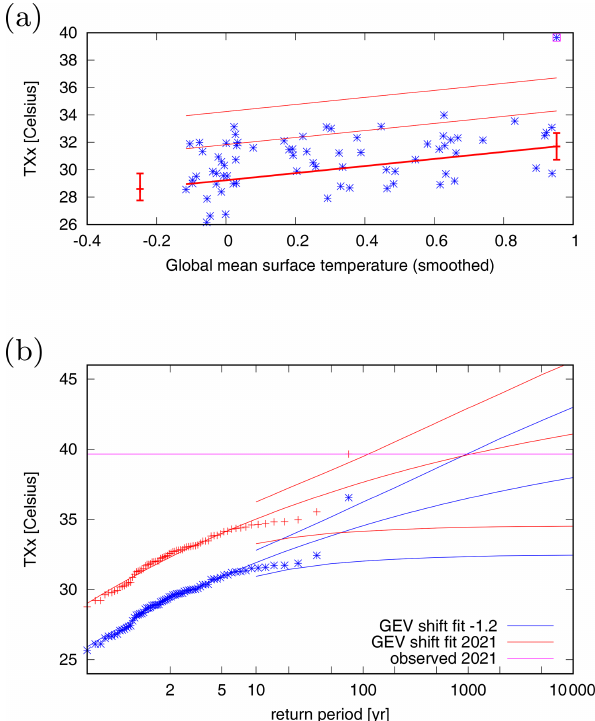
Figure 8. As for Fig. 6 but including data from the 2021 heat wave into the